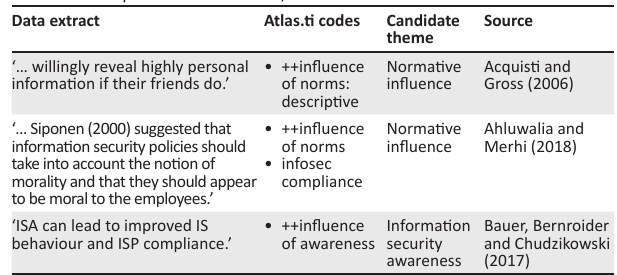
TABLE 1: Example of coded extracts, associated themes and sources. Data